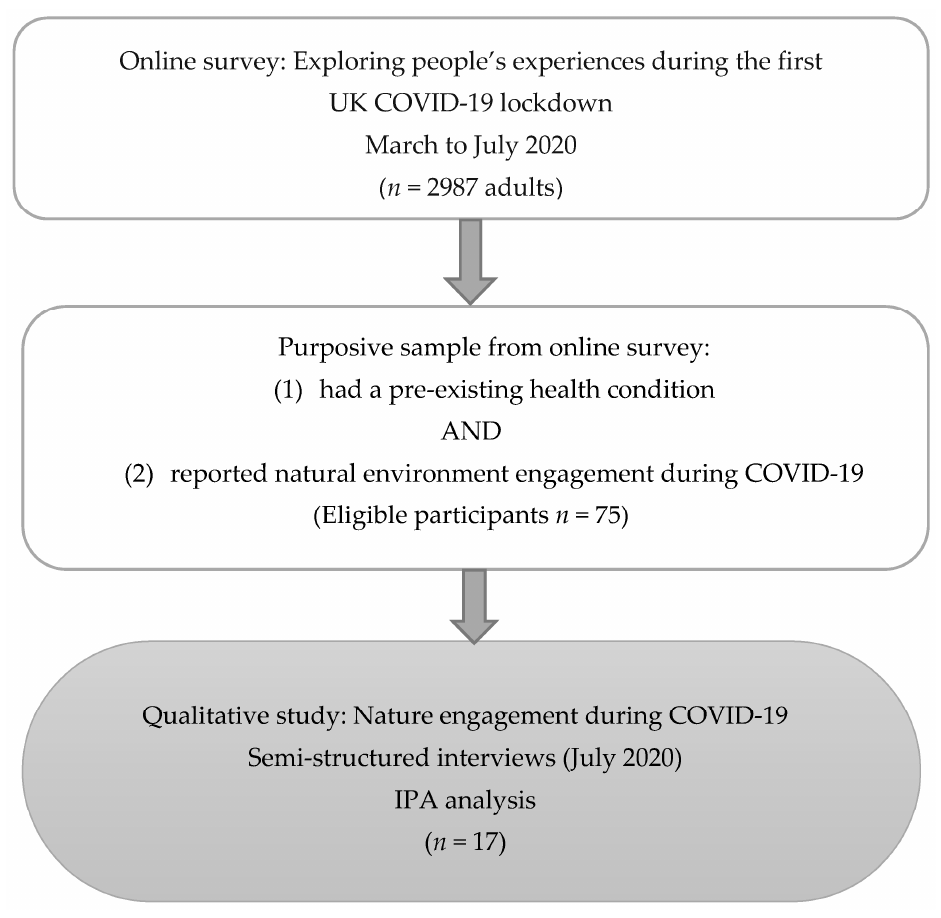
Figure 1. Study flow chart.